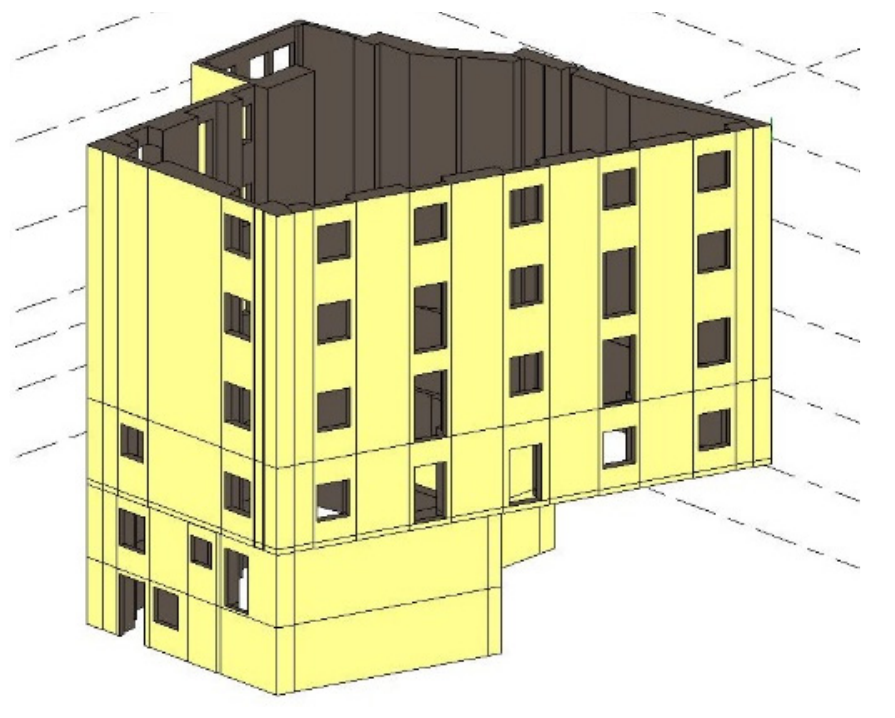
Figure 5. Model of the façade walls.